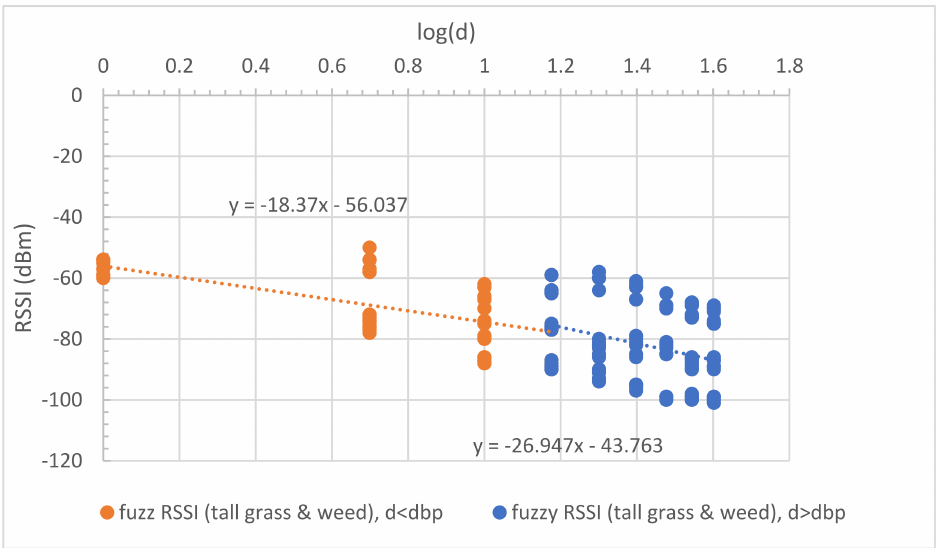
Figure 5. Uncertainty in observed RSSI and distance of tall grass and weed, for all antenna heights.